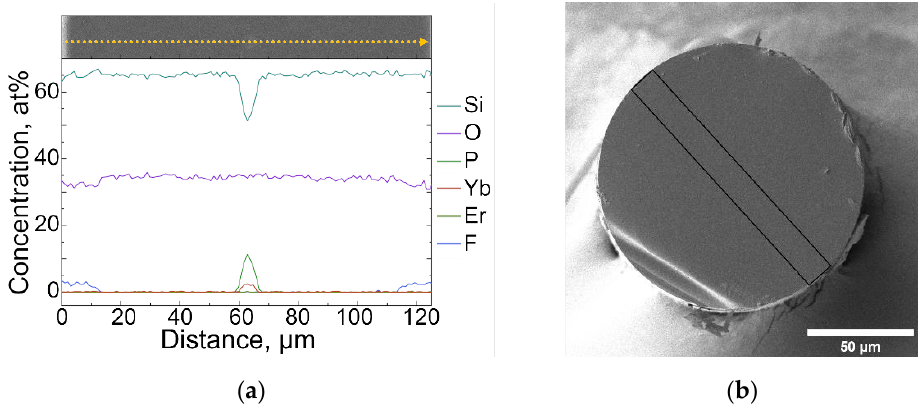
Figure 1. ( a ) EDS line scan represented by the yellow dotted line with the corresponding elemental distribution underneath; ( b ) EYDF cross-section where the black rectangle is the EDS line scan region.